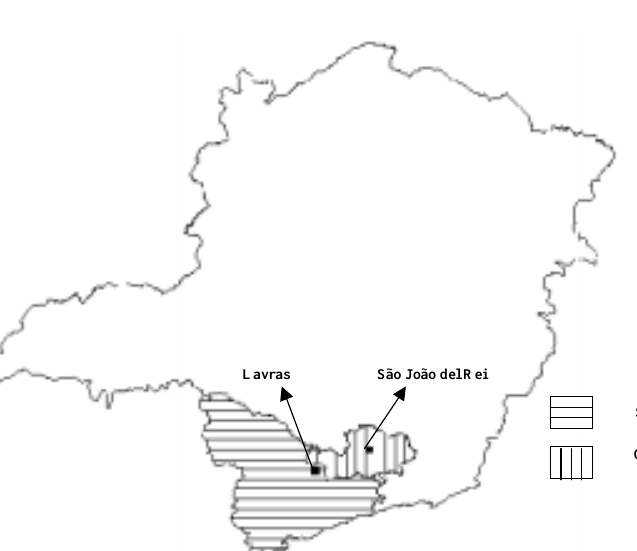
Figura 1. Zonas fisiográficas Sul e Campos das Vertentes do estado de Minas